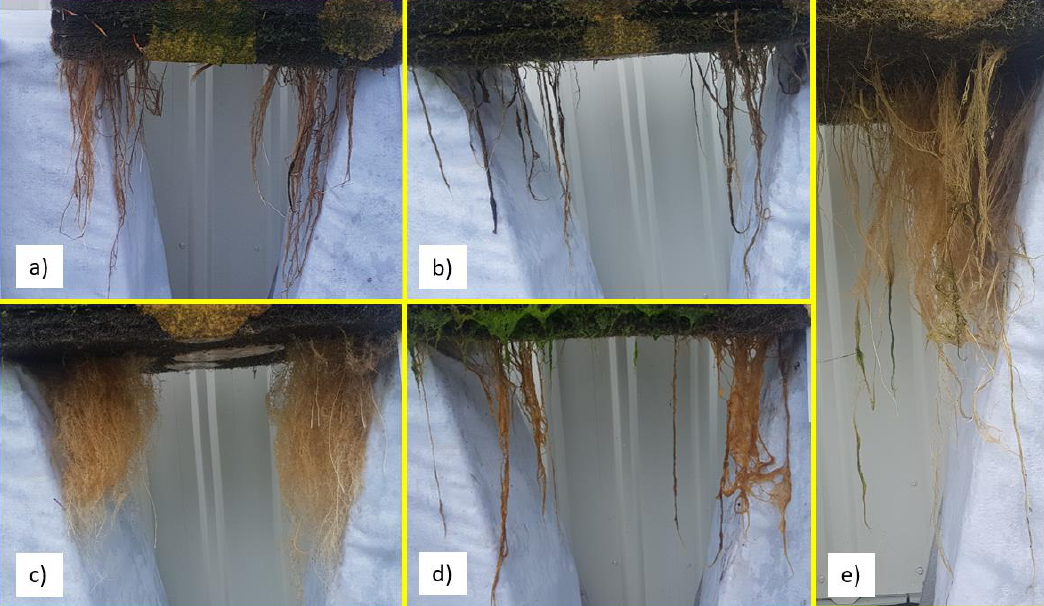
Figure 7. Root Systems of ( a ) Baumea juncea ; ( b ) Isolepis nodosa ; ( c ) Chrysopogon zizanioides ; ( d ) Sarcocornia quinqueflora and ( e ) Phragmites australis plants.